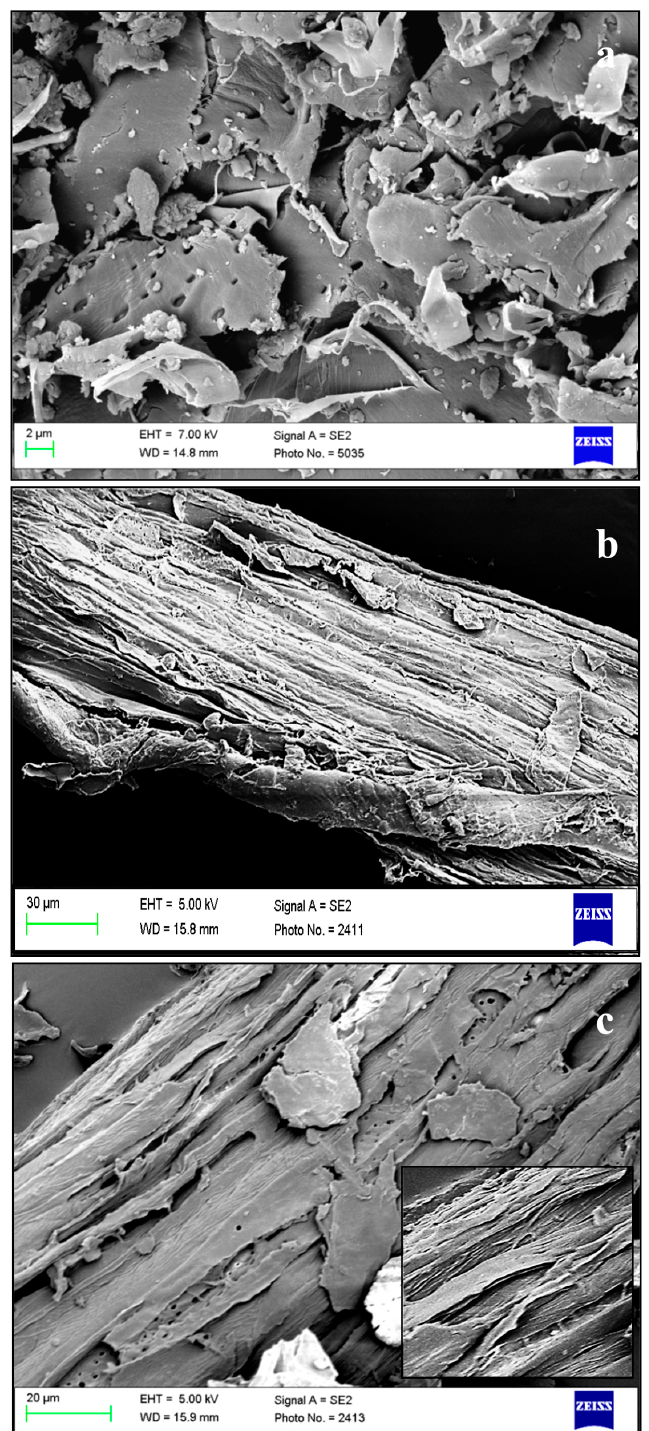
Figure 1. SEM images of HHB at different stages of microfibres extraction: ( a ) raw; ( b ) ATH and ( c ) AHH.